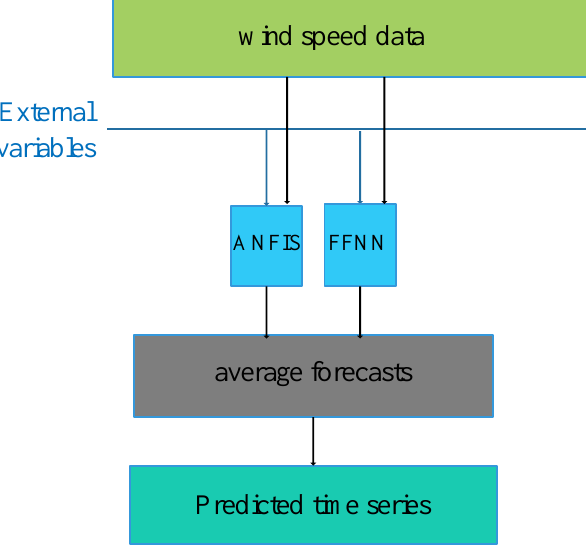
Figure 3. Structure of the proposed forecasting model.